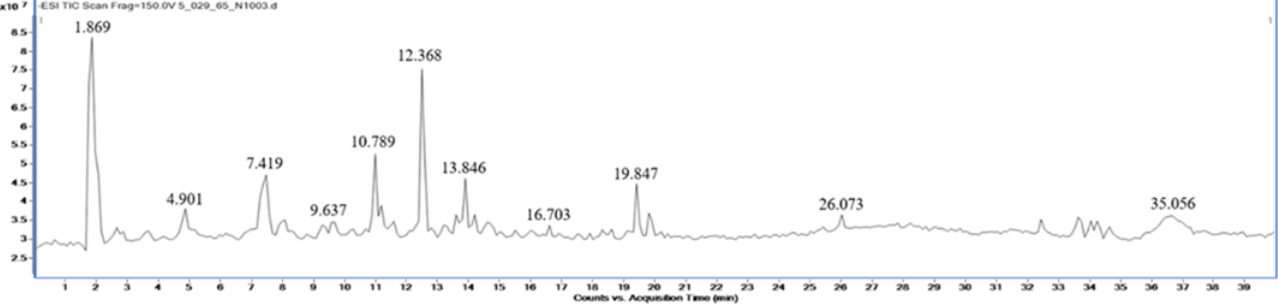
Figure 2. LC-MS chromatogram of ethanolic A. lancea rhizome extract. Table 4. Compounds identified in the ethanolic extract of Prabchompoothaweep remedy by LC- QTOF-MS.